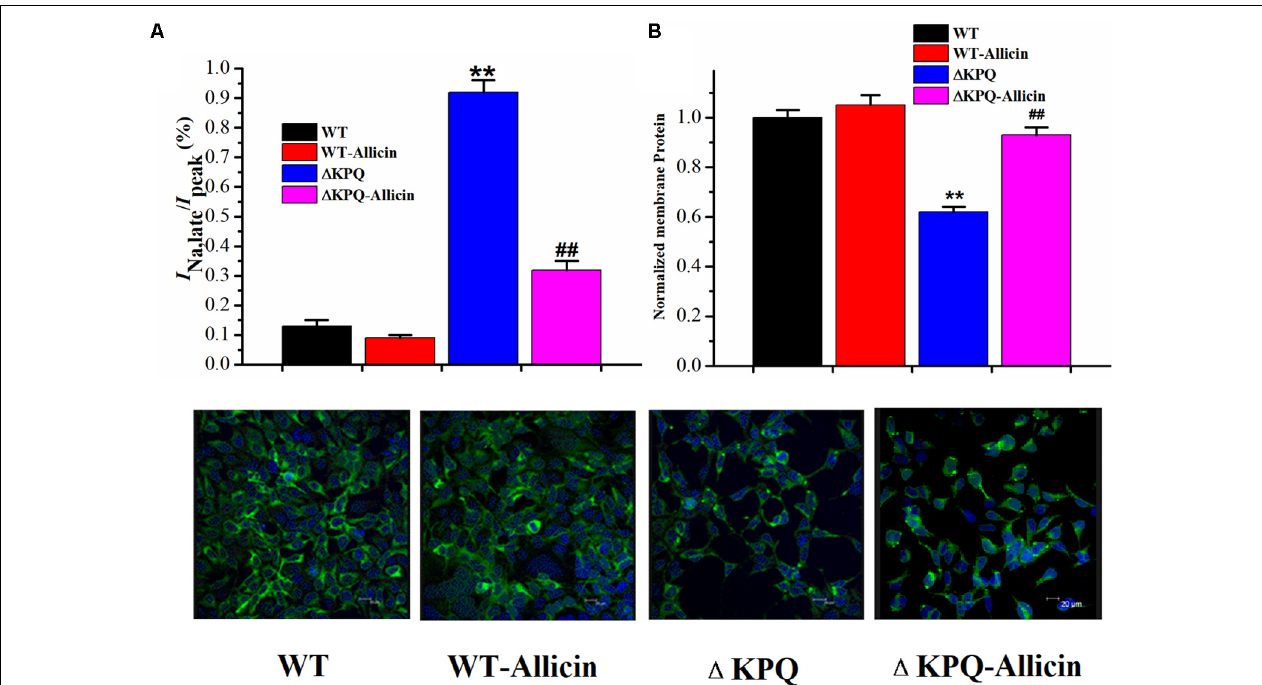
FIGURE 6 | Effect of Allicin on the ratio of the I Na , L / I Na , P and the cellular distribution of the Nav1.5 channel protein on the plasma membrane. (A) The incremental ratio of the I Na , L / I Na , P of the (cid:49) KPQ-SCN5A mutation current was decreased from 0.94% ± 0.04% to 0.32% ± 0.02% under the effect of 30 µ M Allicin, which was close to the WT. (B) Confocal imaging of the Nav1.5 channel protein expression on HEK293 cells in the WT, WT-Allicin, (cid:49) KPQ, and (cid:49) KPQ-Allicin groups. ∗∗ P < 0.01 vs. WT group; ## P < 0.01 vs. (cid:49) KPQ